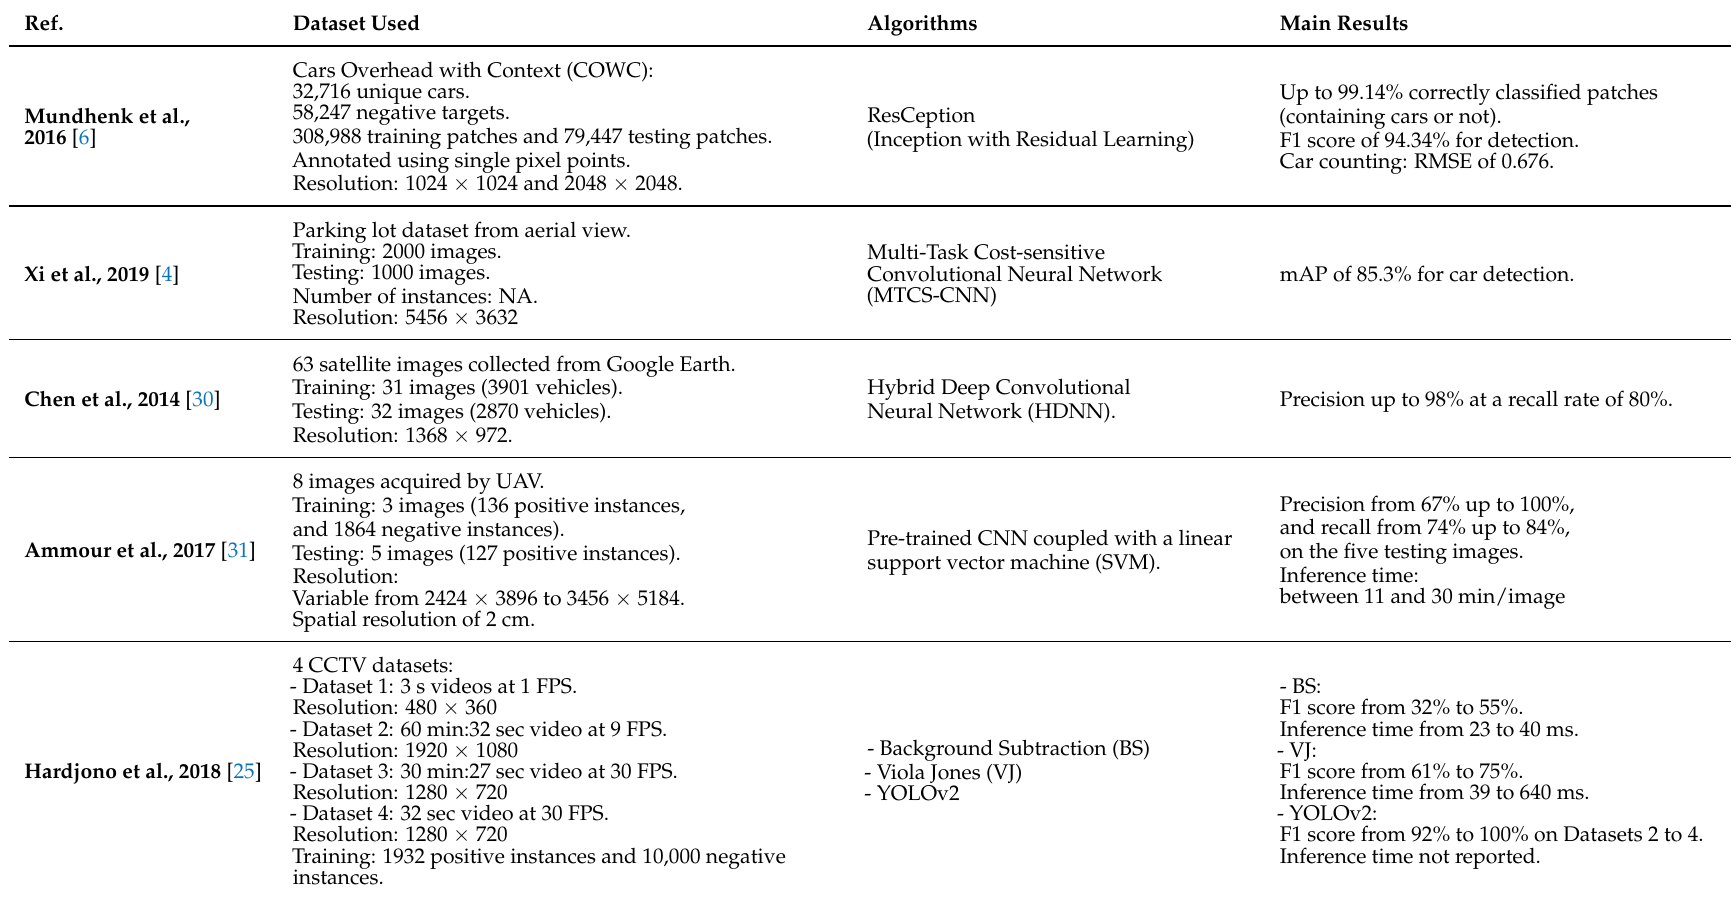
Table 1. Comparison of our paper with the related